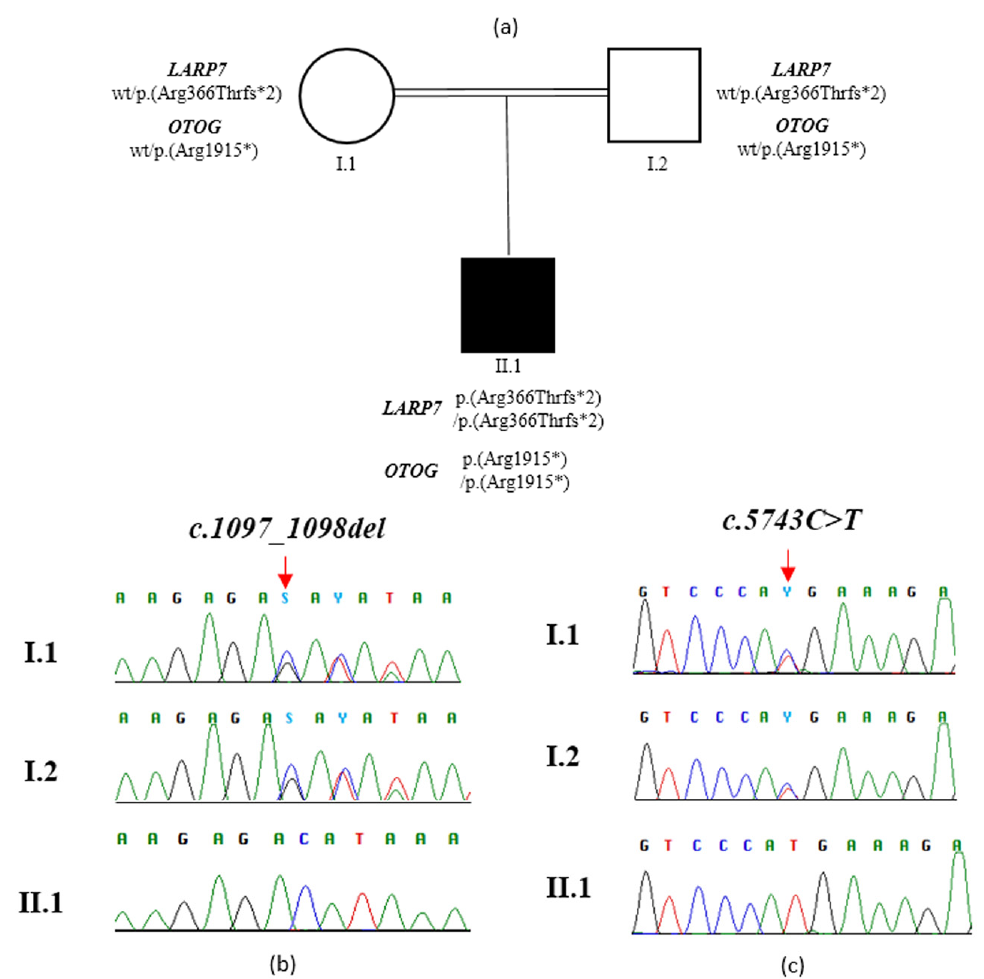
Figure 2. Family tree and molecular findings in the family. ( a ) Double lines in pedigree indicate consanguinity. Filled and unfilled circles / squares represent a ff ected and una ff ected individuals respectively. ( b ) Sanger sequence of a PCR product amplified with primers targeting exon 8 of LARP7 of individual II.1 and his una ff ected parents. ( c ) Sanger sequence of a PCR product amplified with primers targeting exon 35 of OTOG of individual II.1 and his una ff ected parents. Vertical red arrows indicate variant